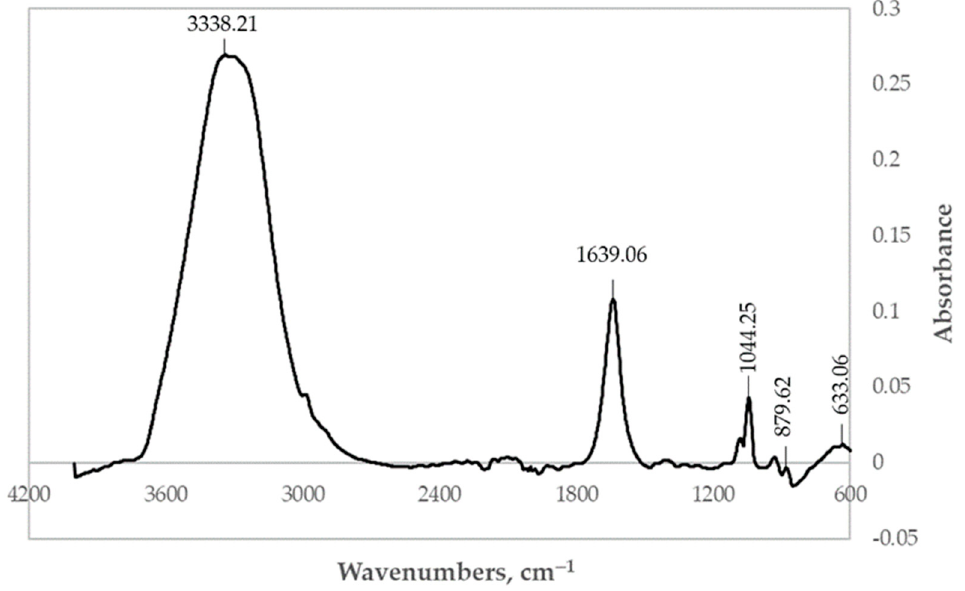
Figure 4. FTIR spectra of pineapple wine measured in range 4000–600 cm − 1 with a resolution 2 cm − 1 and 32 scans.